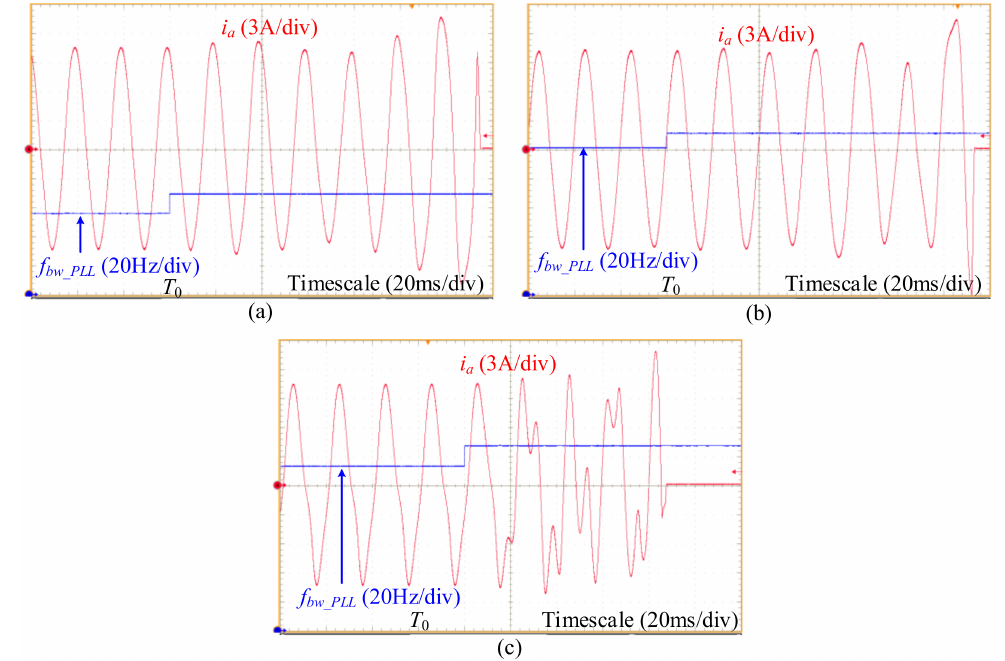
Figure 12. A-phase current waveforms for the converter using ( a ) implementation I; ( b ) implementation II; ( c ) implementation III of the adaptive resonance controllers with f bw_pll changes at time T 0